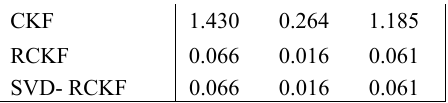
Table 4. Position errors of different filters in case 2